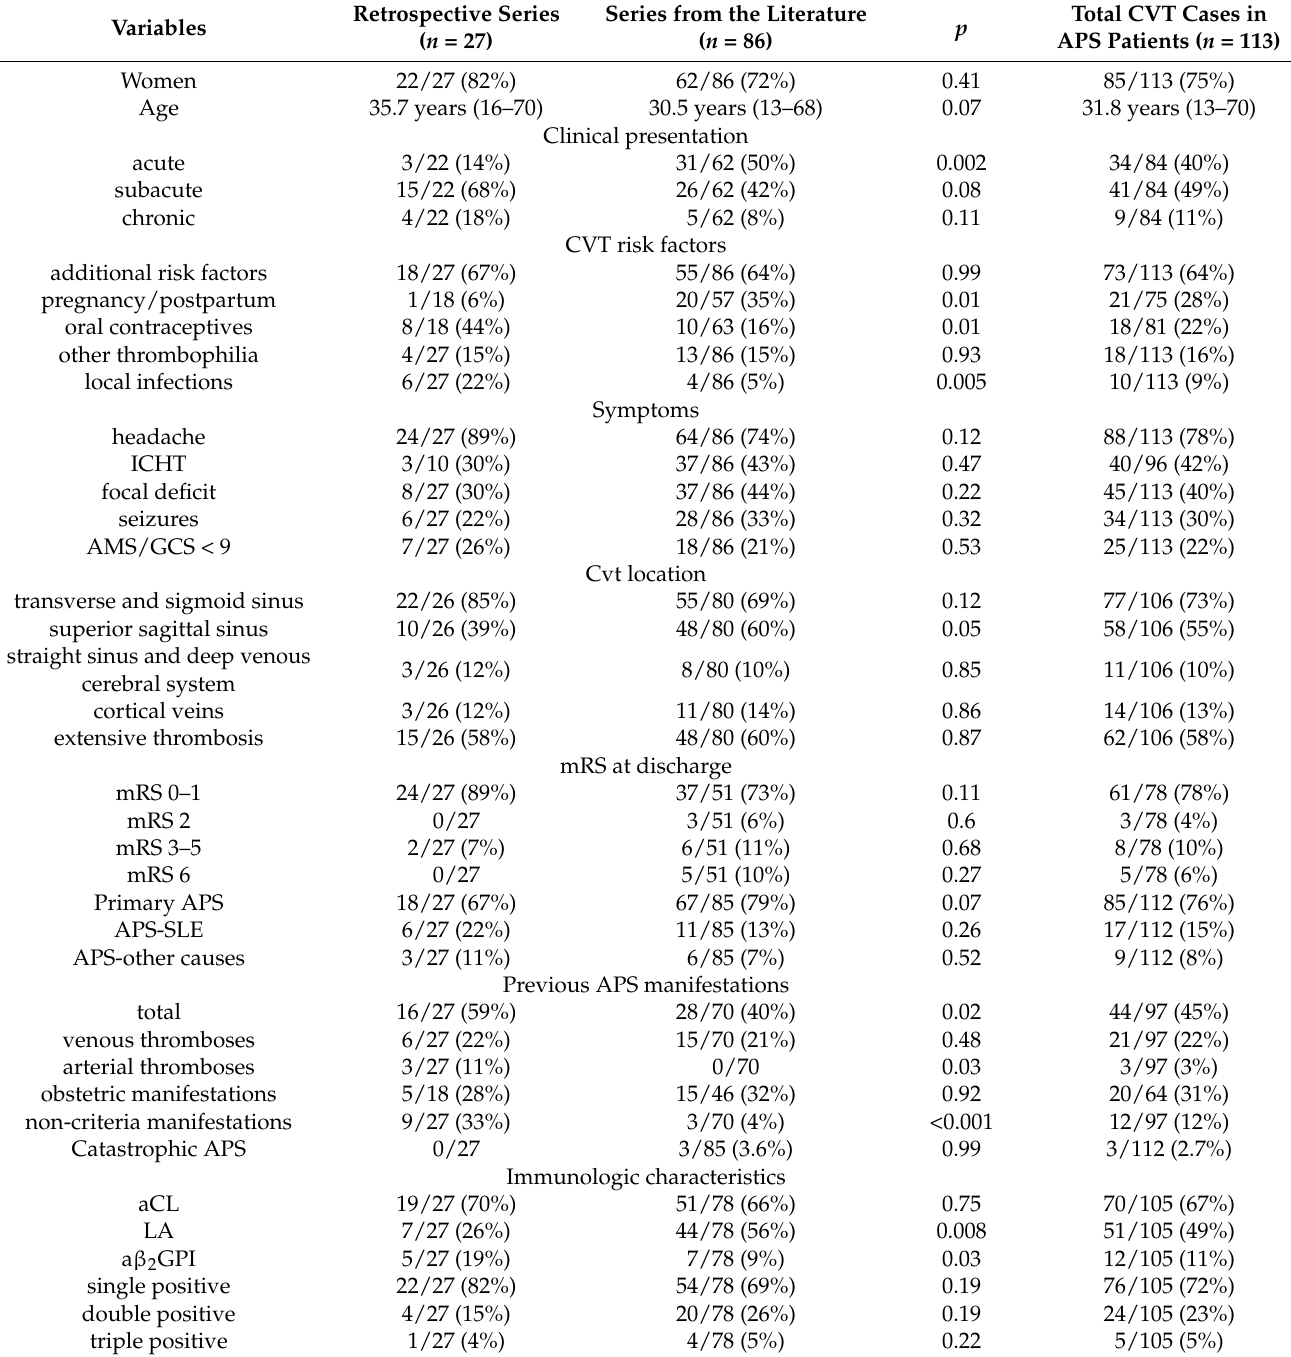
Table 6. Clinical characteristics of the CVT in the literature compared to our series. The last column describes the characteristics of the APS patients presenting with a CVT (both from the literature and our series). Abbreviations: CVT, cerebral vein thrombosis; APS, antiphospholipid syndrome; ICHT, intracranial hypertension; AMS, altered mental status; GCS, Glasgow Coma Scale; mRS, modified Rankin Scale; LA, lupus anticoagulant; aCL, anticardiolipin antibodies; a β 2 GPI, anti- β 2 -glycoprotein-I